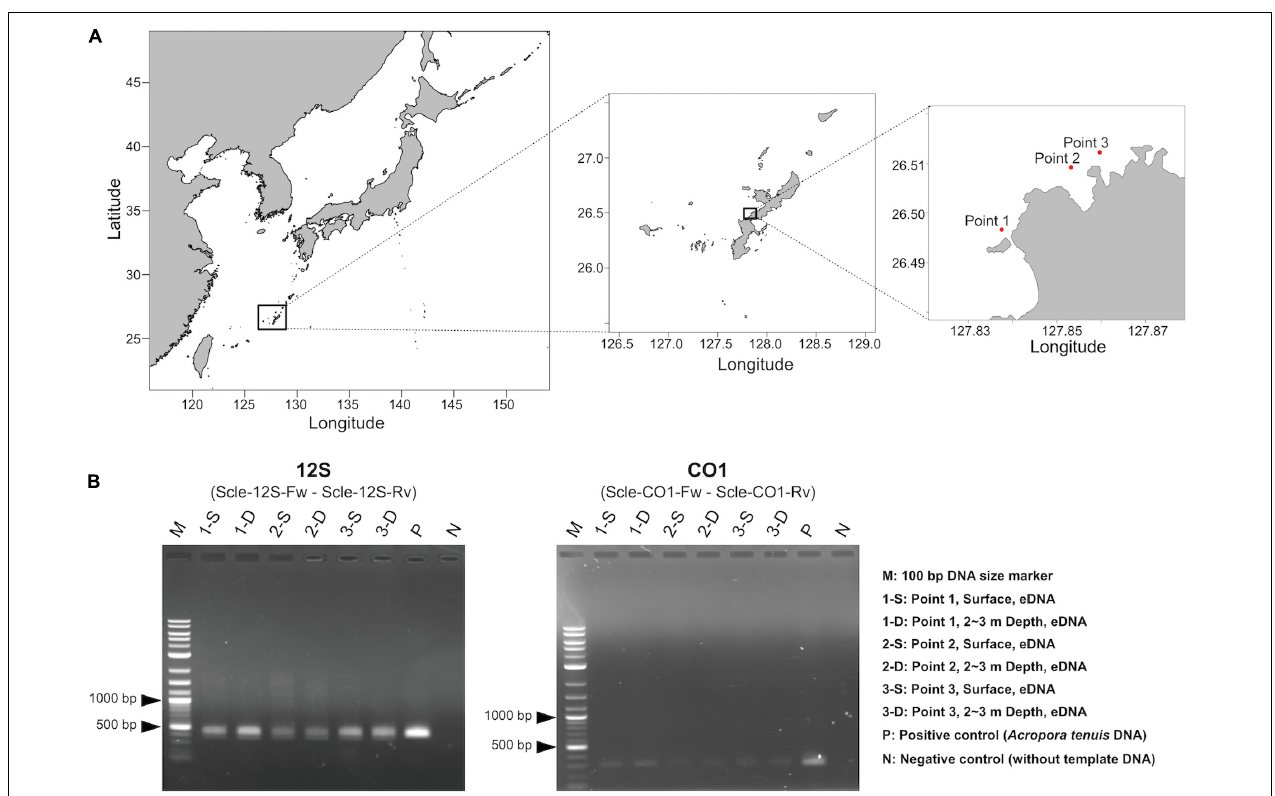
FIGURE 3 | Water sampling and PCR amplification of extracted eDNA. (A) Maps showing three sampling locations (red dots). Shapefiles were downloaded from Nature Earth (https://www.naturalearthdata.com/) and Global Administrative Areas (https://gadm.org), and were visualized as maps using maptools in R, version 4.1.0. Exact sampling locations, sampling times, and distances between sampling locations are available in Supplementary Table 2 . (B) PCR amplification of eDNA using the designed primers for 12S (left) and CO1